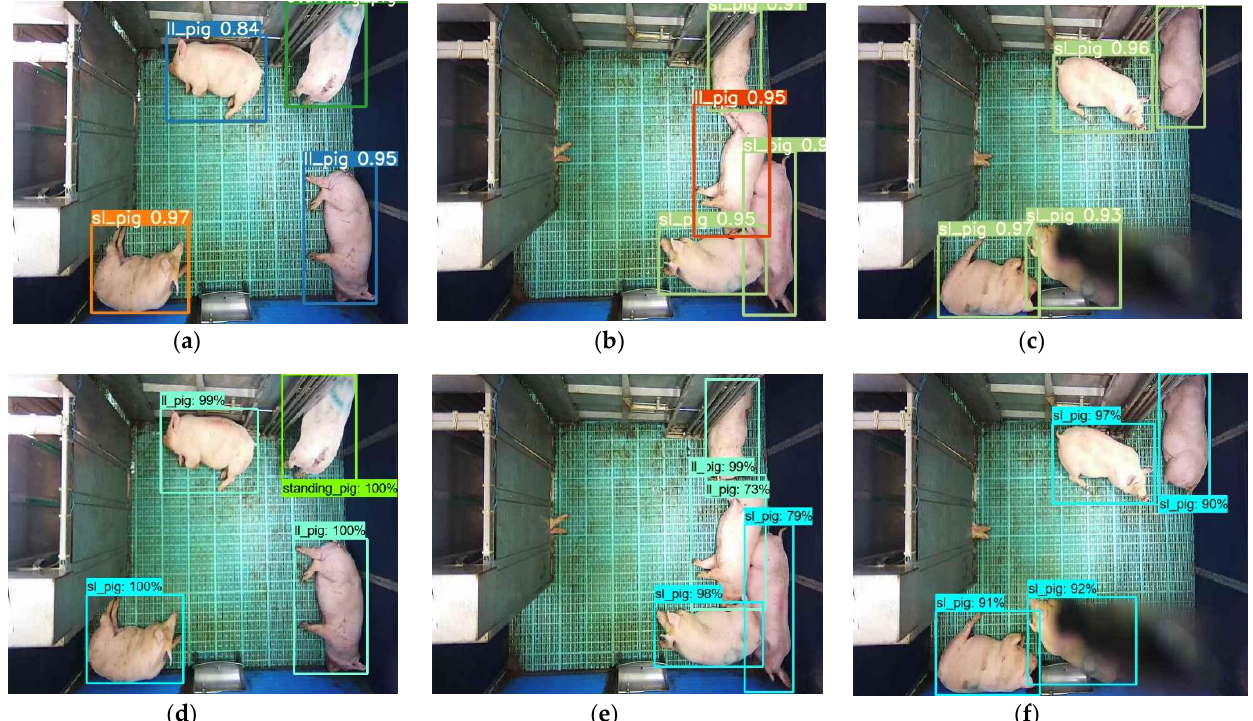
Figure 10. Class-wise and overall precision-recall evaluation metrics of the model: ( a ) YOLOv4 model and ( b ) Faster R- CNN model.